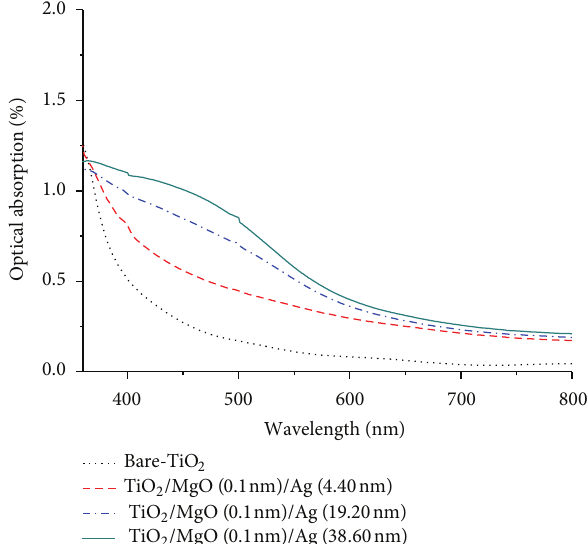
Figure 8: Optical absorption spectra of the bare-TiO 2 compared withtheTiO 2 /MgO/AgcompositefilmswithvariedAgnanoparticle size in range of 4.40–38.60 nm.